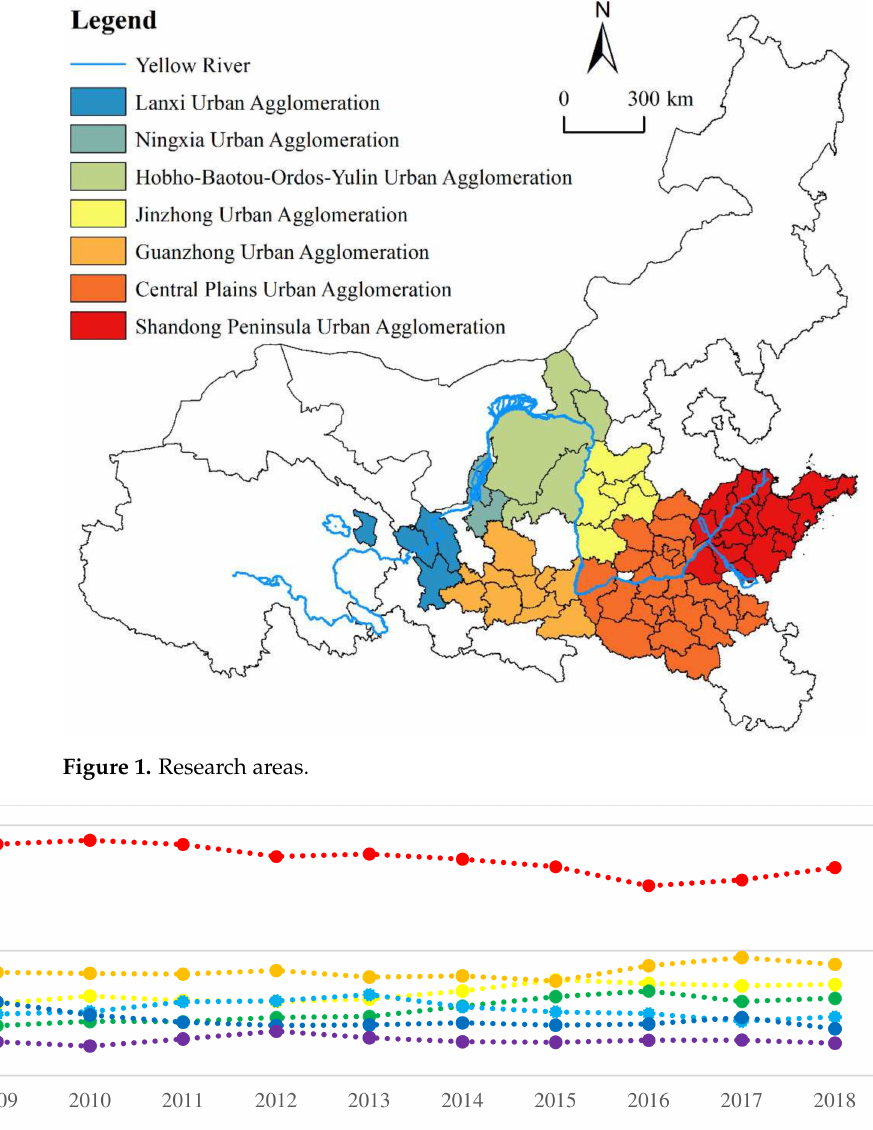
Figure 2. Temporal change in the HQD level of seven urban